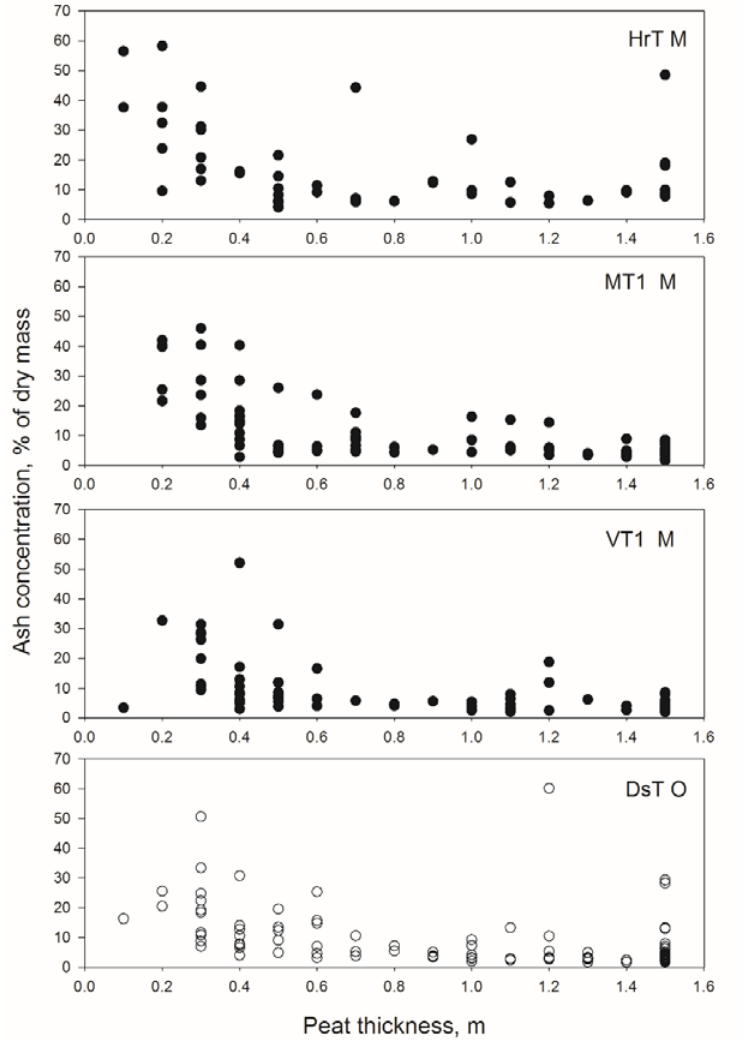
Figure 3. Variation in ash concentration (% of peat dry mass) in a 0–30 cm surface peat layer, relative to thickness of the peat deposit, within four floristically defined peatland site types. The maximum peat thickness measured was 1.5 m; i.e., the 1.5 m thickness point also includes sites with peat thickness > 1.5 m. Based on the data of Westman & Laiho (2003). Site types and sample characteristics as in Figure